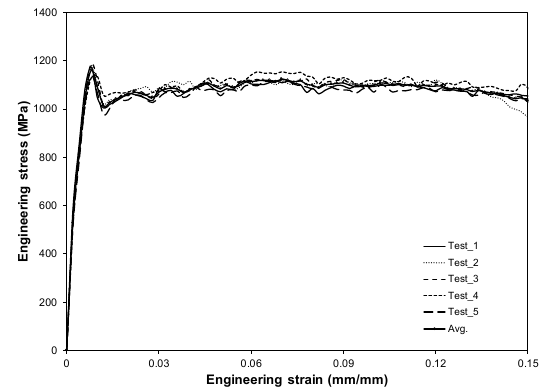
Fig. 8. Experimental engineering stress strain for Material 2 at 10 s -1 .